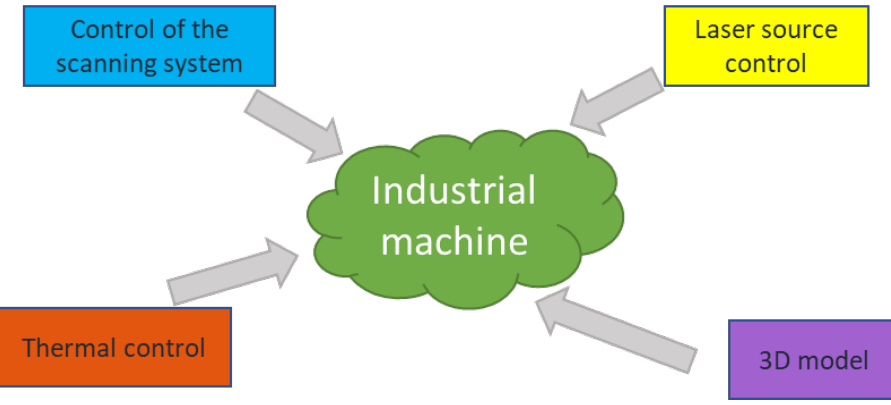
Figure 8. From technological issues to